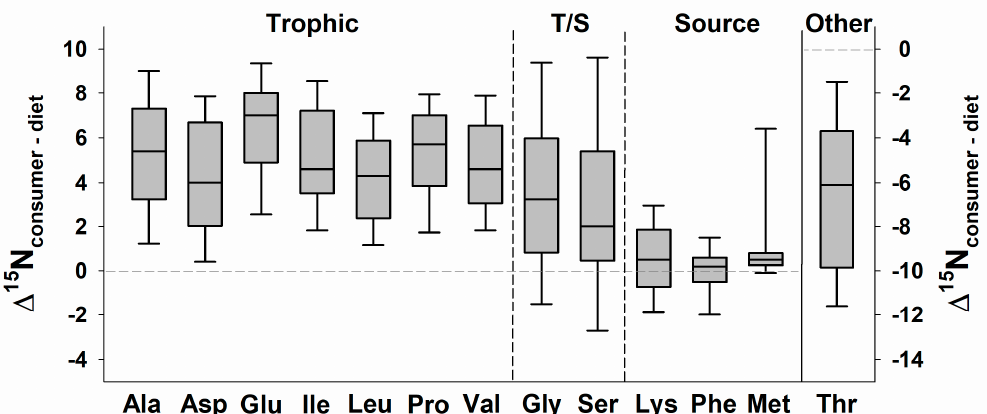
Figure 4. Median values (solid line; boxes and error bars represent 25th and 10th percentiles) of the nitrogen isotope discrimination factors ( ∆ 15 N C-D , or δ 15 N Consumer tissue − δ 15 N Diet item ) for individual amino acids (AA) across 58 species of consumers in controlled experiments and well-constrained field studies. AA that are trophic tend to have greater ∆ 15 N C-D values in comparison to source AA. Note that T/S indicates AA that can be classified as either trophic or source, and that threonine has a separate y-axis. Of the 20 standard AA, five are excluded here because they are rarely reported (arginine, cysteine, histidine, tryptophan, tyrosine). In addition, during sample preparation, glutamine is converted to glutamic acid and asparagine to aspartic acid. Studies were located (1) in Supplement 1 of [31]; and (2) by repeating the literature search described in [31] to add more recent studies. Studies are listed in Table S2.